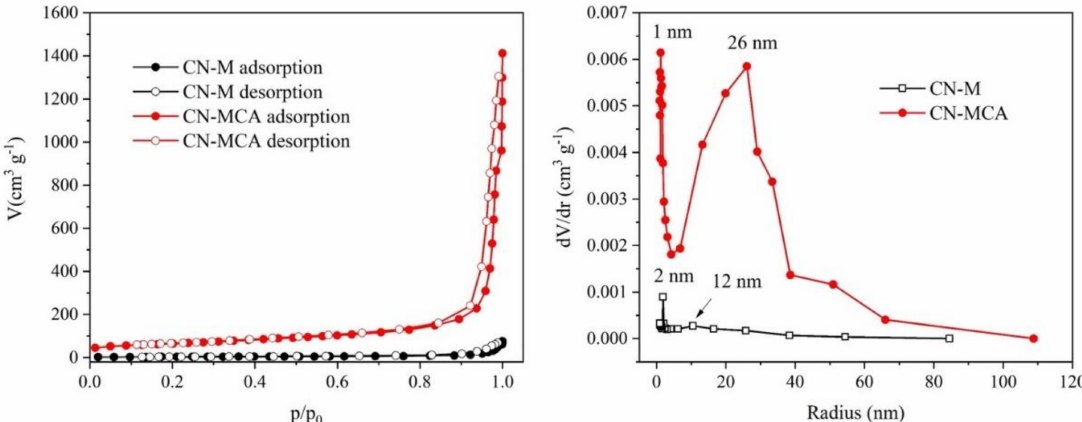
Figure 2. Adsorption and desorption isotherms of nitrogen at 77 K ( left ) and distribution curves ( right ) of CN-M and CN-MCA.